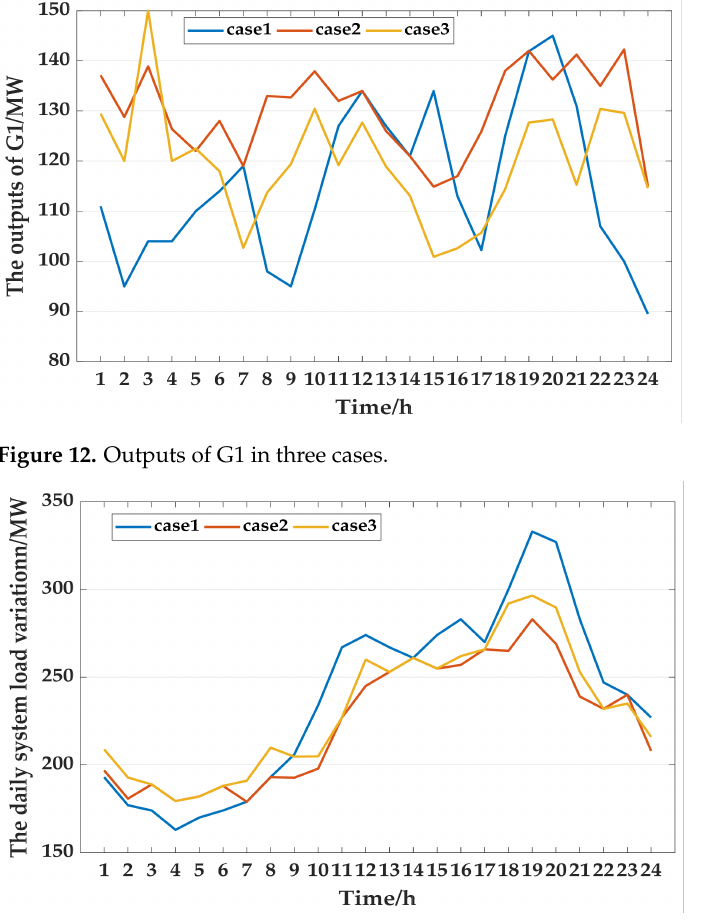
Figure 13. Variation in daily system load curve. In Figure 14, C t represents the total cost, and C f , C ss and C dr are the costs of thermal units, startup and shutdown and DR, respectively.